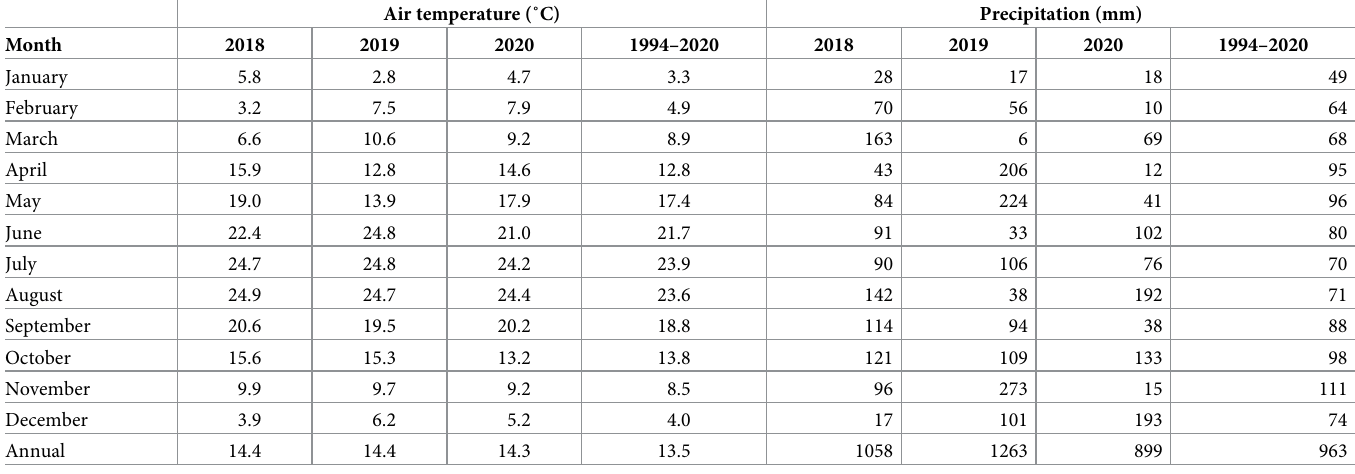
Table 1. Monthly mean air temperatures and monthly precipitation during the study period, and long-term averages (1994–2020) at Arqu à Petrarca, north-eastern Italy. Air temperature (˚C) Precipitation